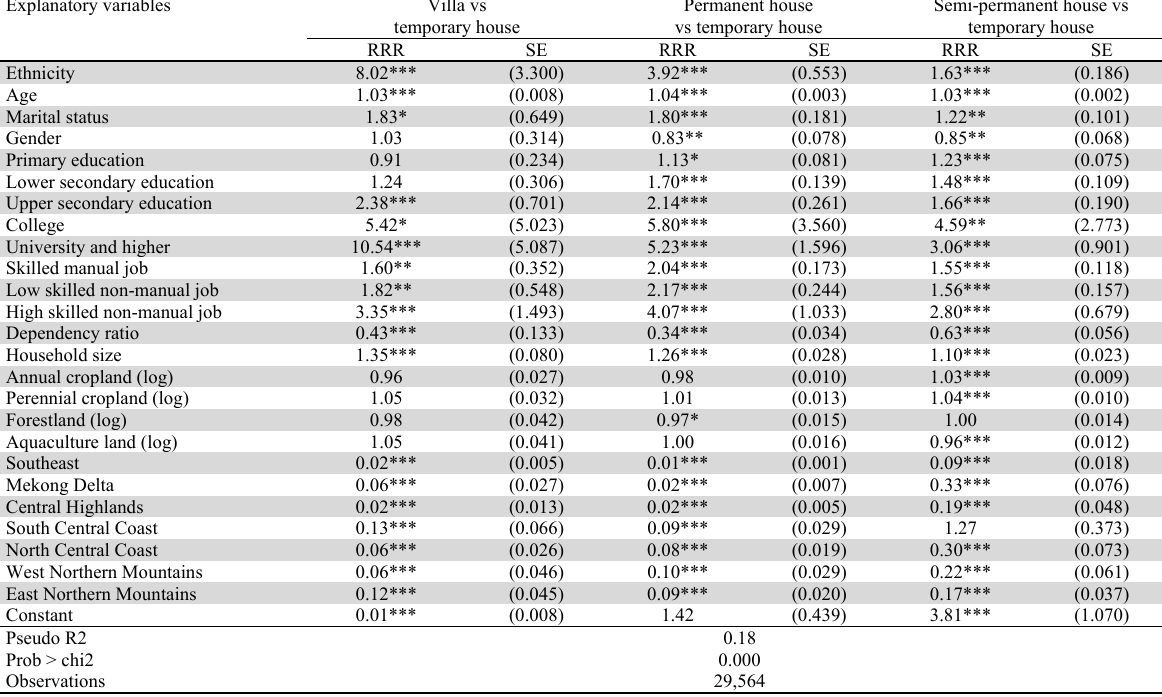
Table 3 Factors associated with house types (Multinomial regression model) Explanatory